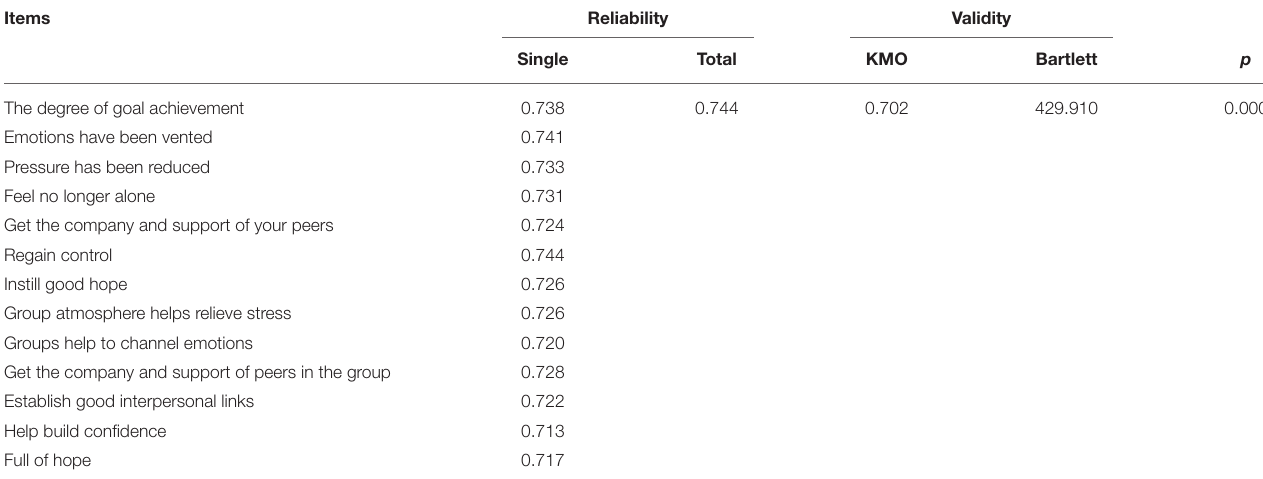
TABLE 4 | Reliability and validity analysis of leaders’ goal achievement.